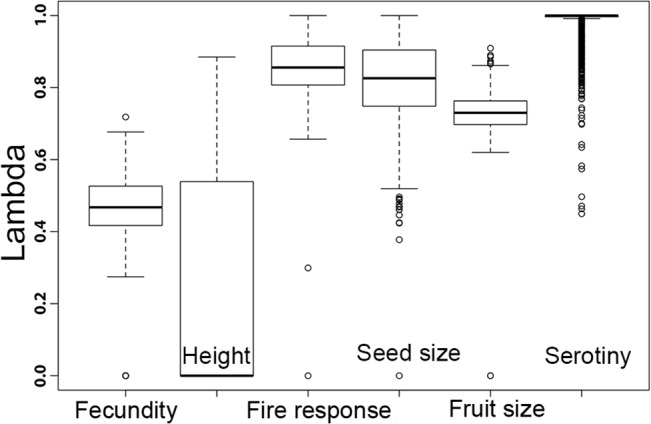
Distribution of lambda values among 1000 simulations indicating the degree of phylogenetic constraints on six traits in Hakea.Means are shown by thickened horizontal lines, standard deviations are bounded by boxes and ranges are connected by broken lines, and circles are outliers.